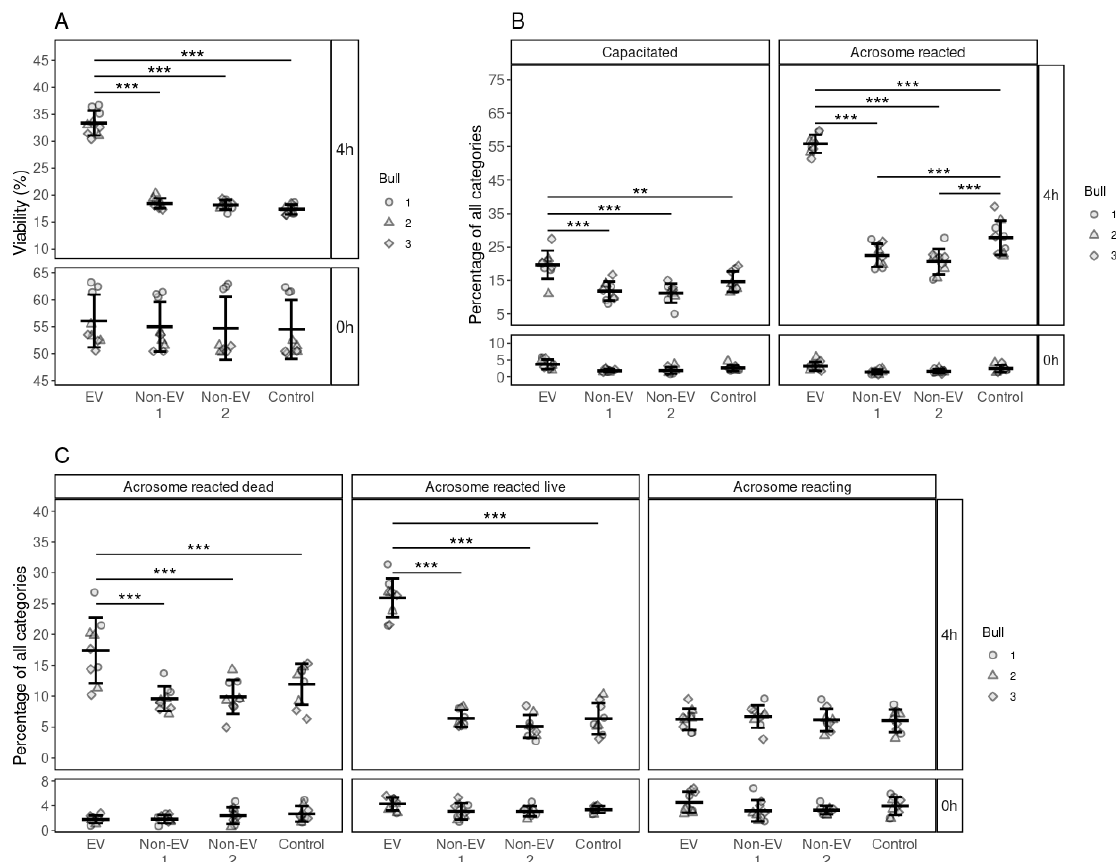
Figure 2. The effects of supplementing FF EV and non-EV fractions on the viability, capacitation and acrosome reaction of spermatozoa. ( A ) The viability of spermatozoa at 0 and 4 h in response to different supplementations. ( B ) The percentage of spermatozoa in the different stages of the capacitation process at 0 and 4 h after supplementation. ( C ) The percentage of spermatozoa in the different stages of acrosome reaction at 0 and 4 h after supplementation. Error bars display the mean ± standard deviation (SD). Different symbols represent measurements of samples from different bulls. Asterisks mark statistically significant differences among the supplementation groups and relate to p -values as follows: ** p ≤ 0.01; *** p ≤ 0.001.